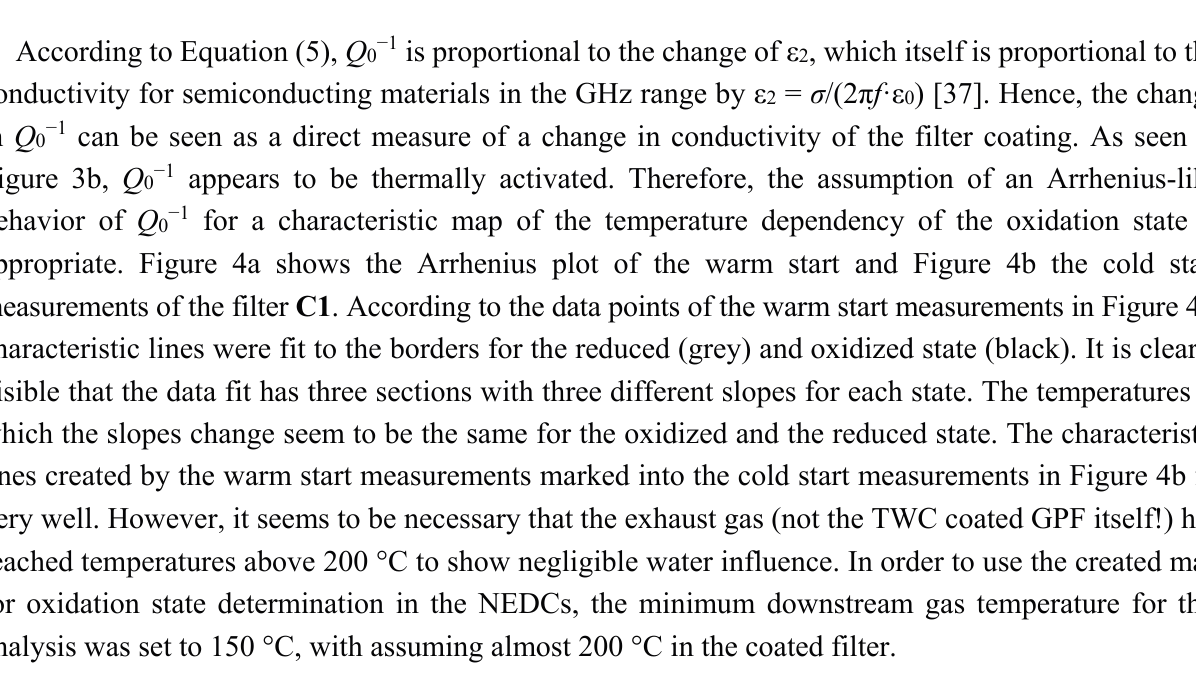
Figure 3. Temperature dependence of ( a ) f res in reverse scale and ( b ) Q 0 − 1 , observed during NEDC (max. 500 °C) and OSC runs (max. 620 °C) under cold and warm start conditions for sample C1 ; each differently colored data set represents one experimental